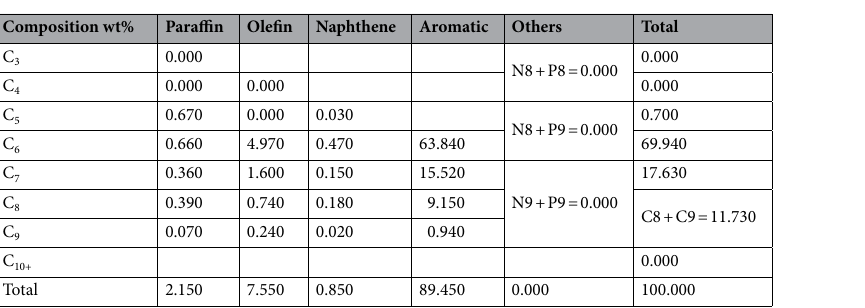
Figure 2. Schematic of the experimental set-up for hydrogenation of PyGas.